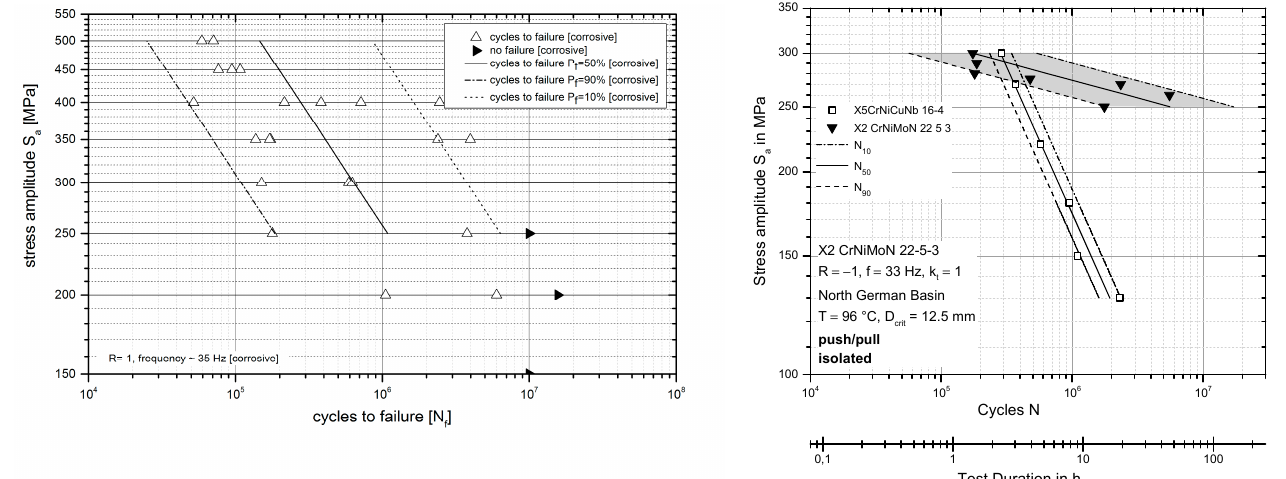
Figure 13. S-N curve and crack formation on the 1.4542 first and second set of experiments exposed to saline aquifer water and technical CO 2 . Comparison results for 1.4462 are given.